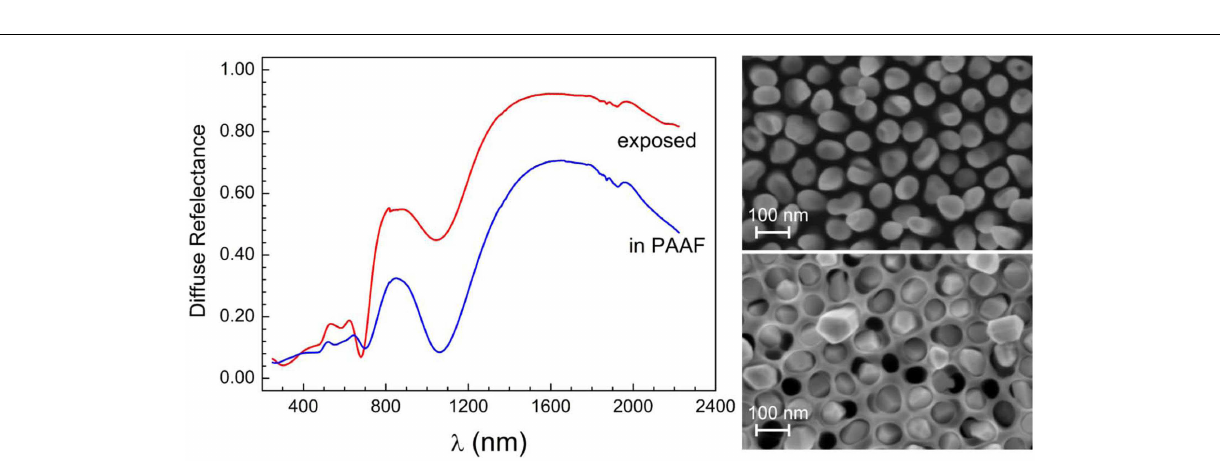
Frontiers in Materials |Thin Solid